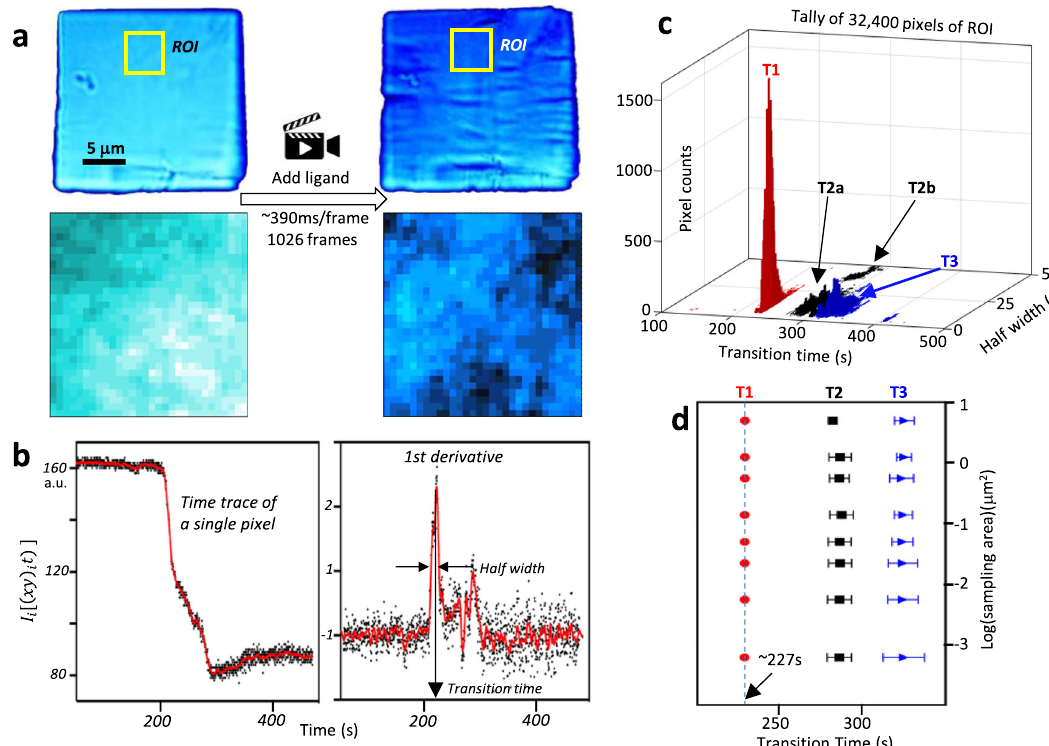
Fig. 1 Ligand-triggered crystal lattice transition observed by PVM. a Video microscopy images of an “ ab ” ( c -axis along the thin edge) riboA crystal before (top left) and after (top right) the phase transition in the presence of 1 mM ligand. The yellow box de fi nes the ~4.5 µ m square (180 × 180 = 32,400 pixels) region of interest (ROI) used for the detailed analysis. The crystal is continuously monitored at the pixel level, starting from the beginning (bottom left) to the end (bottom right). A 30 × 30 pixels square area in the yellow box is used to show the crystal is birefringent at the pixel level before (bottom left) and after (bottom right) the transition. The images are color-enhanced for clear visualization of individual pixels and the nonuniform crystal surface. b Intensity I i [( xy ) i t ] (arbitrary units) vs. time trace (in s) for the single-center pixel of the ROI. Black dots represent the intensities of individual pixels, and the red line is a time average of the derivative with a smoothing window of 15.2 s (left). Derivative − ∂ I i [( xy ) i t )]/ ∂ t vs. time so that peaks represent the maximum rate of intensity decrease (right). Black dots represent the instantaneous derivative at each time point. The red line is a time average of the derivative with a smoothing window of 7.78 s. c Bivariate histogram of peak half-width of transitions 1, 2, and 3 (T1, T2a and b, and T3) ( y -axis) and transition time ( x -axis) for all (32,400) pixels in the ROI. d Transition time vs. size of sampling areas. Time zero in the PVM experiment refers to the fi rst frame (200) used in the digitization. Source data are provided as a Source Data fi